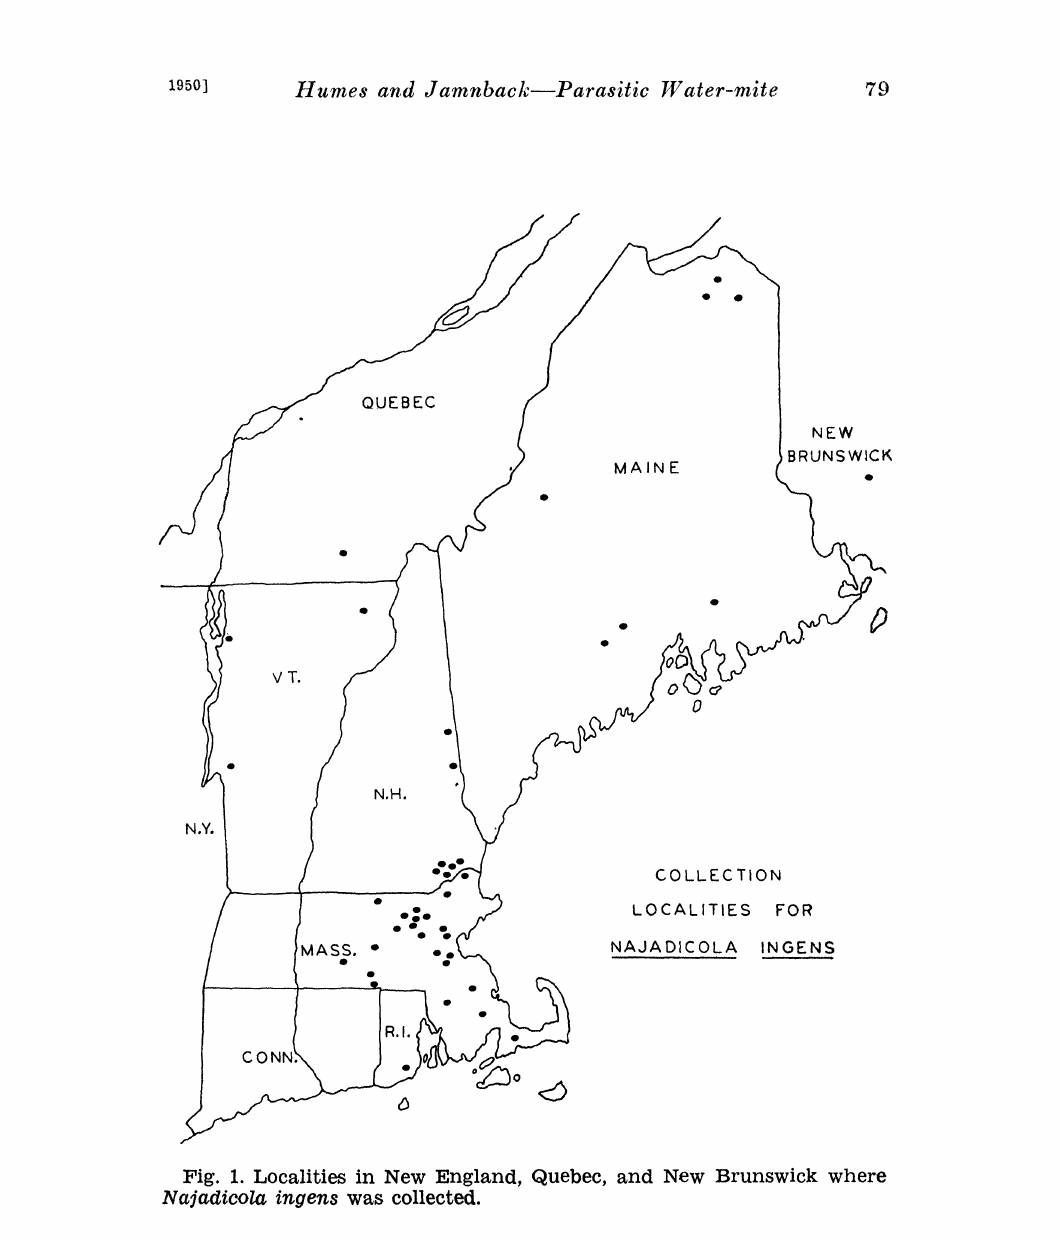
Fig. 1. Localities in New England, Quebec, and New Brunswick where Naiaclicola ingens was